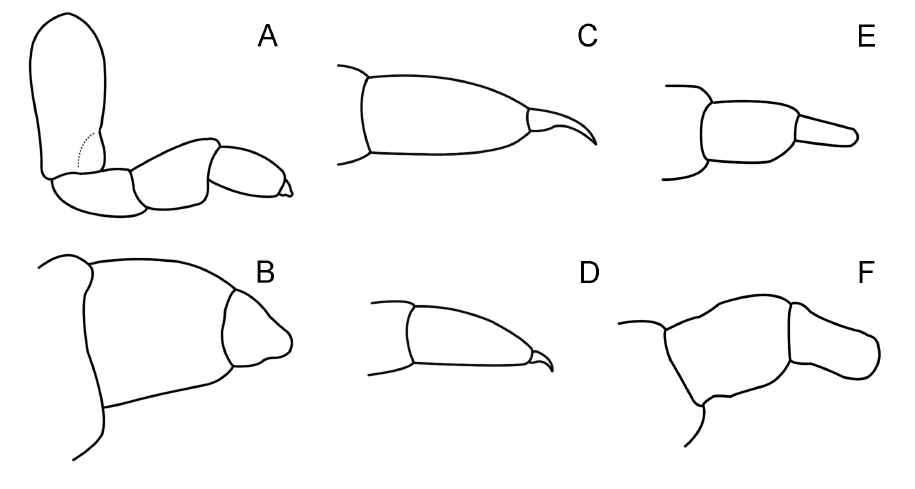
Figure 6. Shape of the terminal claw in European fruits chafer larvae. A leg of Osmoderma eremita B last two segments and claw of O. eremita C idem of Gnorimus variabilis D idem in Trichius fasciatus E last three segments in Cetonia aurata F last three segments in Protaetia cuprea (outlined by Federico Romiti). second and third pairs of legs (instead of being present on the ventral side of mandibles and dorsal side of maxillae as in